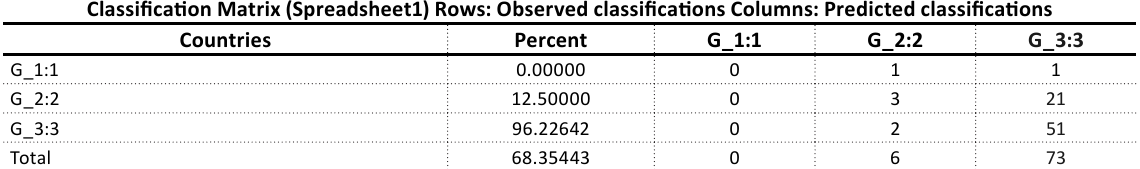
Table C1. Classification matrix of discriminant mathematical model